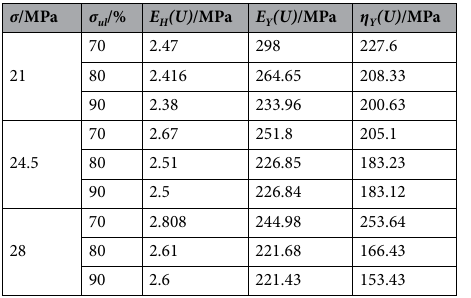
Table 6. Identification parameters of pre-peak unloading damage model under non-yield stress conditions.